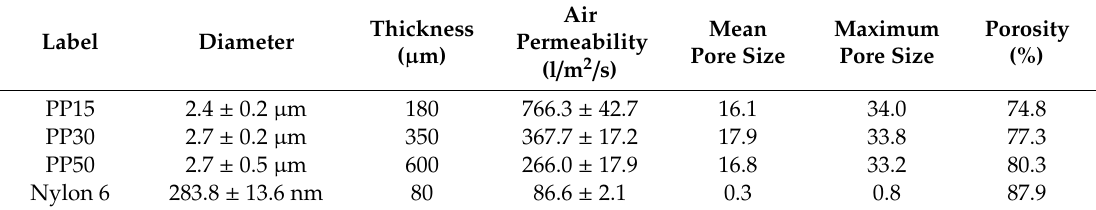
Figure 2. ( a ) Pore size distribution, and ( b ) maximum and average pore diameter of the nonwoven PP according to the basis weight and the nylon 6 nanofiber mat. Table 1. Basic properties of the nonwoven PPs and nylon 6 nanofiber